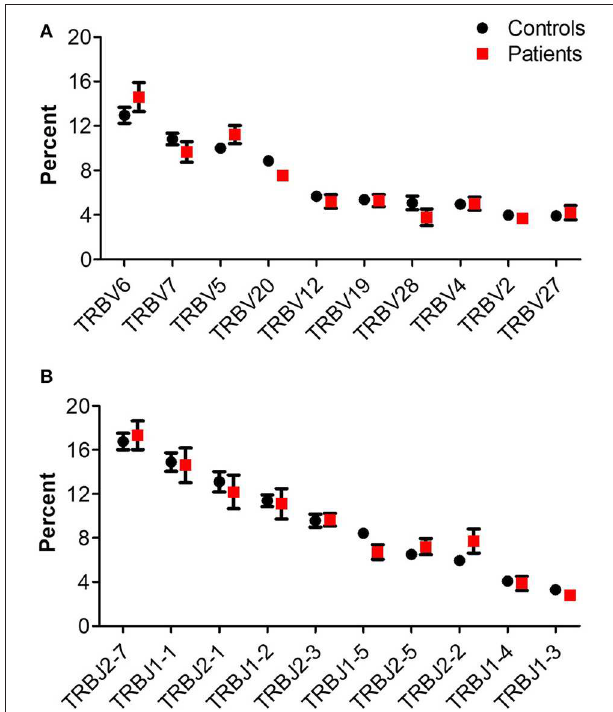
FIGURE 1 | TRB gene usage in patients with IL10/IL10R defects and controls. Comparison of usage of the 10 most frequently used (A) TRBV and (B) TRBJ genes between control and patient groups.